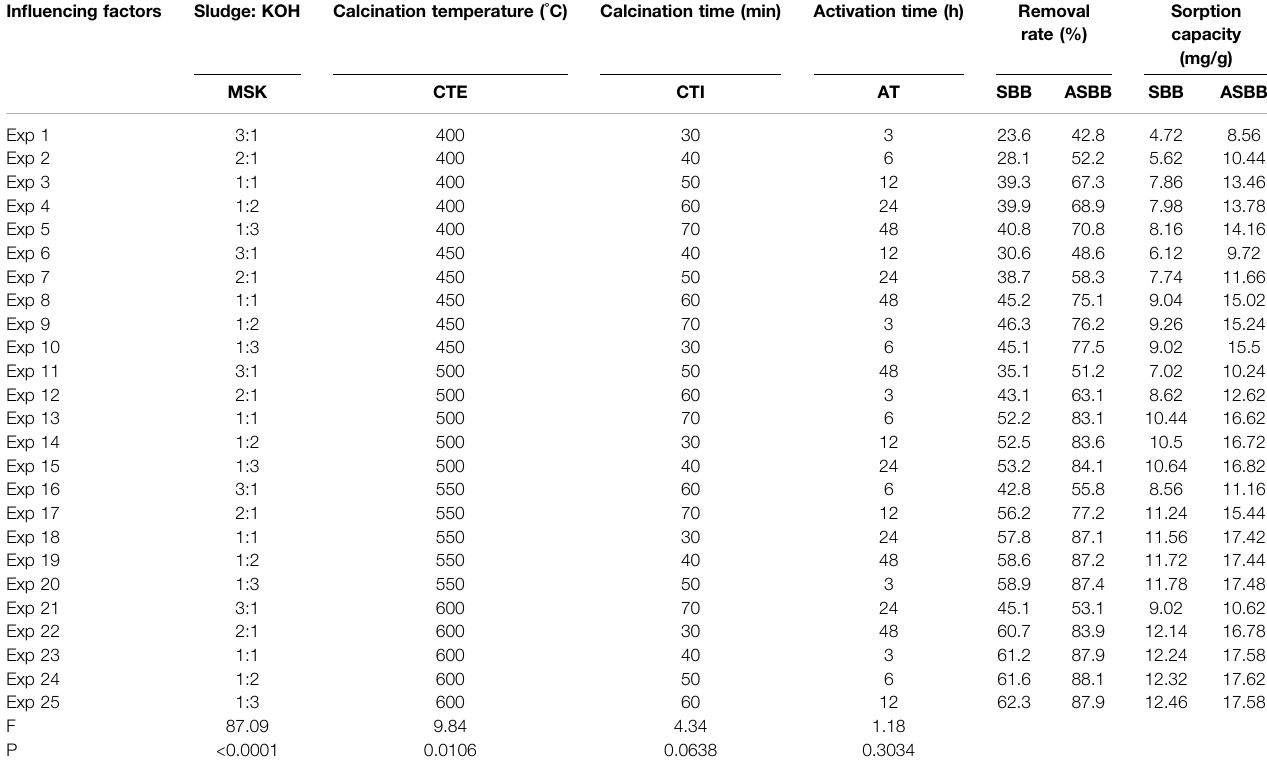
TABLE 1 | Effect of biochar on uranium-containing wastewater (UCW) treatment under different preparation conditions. In fl uencing factors Sludge: